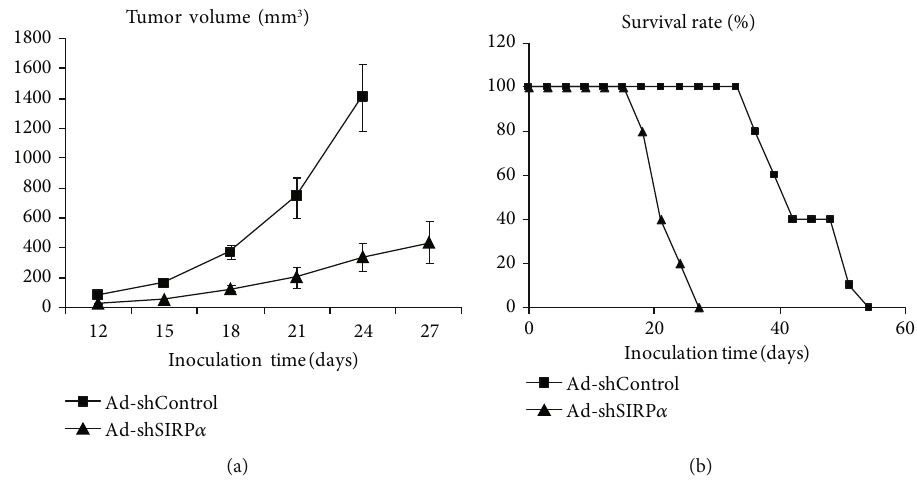
Figure 5: In vivo antitumor activity analysis. The therapeutic e ff ect of SIRP α -silenced DCs was evaluated in cervical tumor xenografted C57BL/6 mice. Data are representative of three independent assays. The tumor volume after inoculation of TC-1 cells was analyzed using Student ’ s t -test. p < 0 : 01 (Ad-shSIRP α vs. Ad-shControl). Survival rates were analyzed using the Kaplan-Meier method (log-rank test). p < 0 : 01 (Ad-shSIRP α vs.